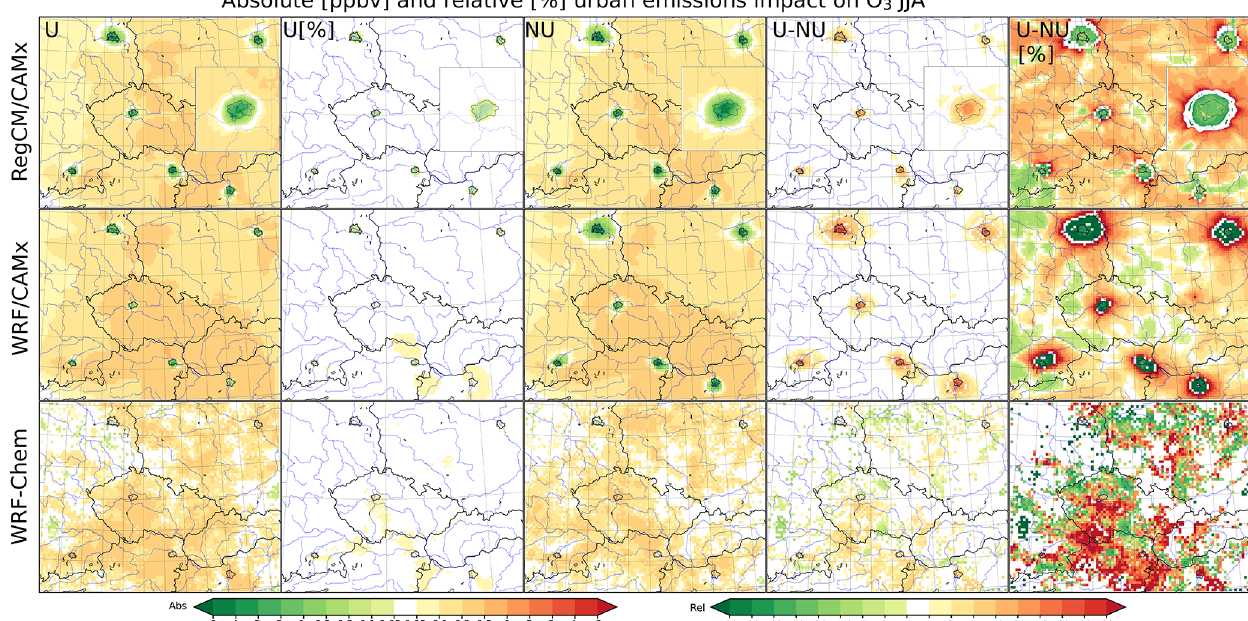
Figure 8. Same as Fig. 5 but for O 3